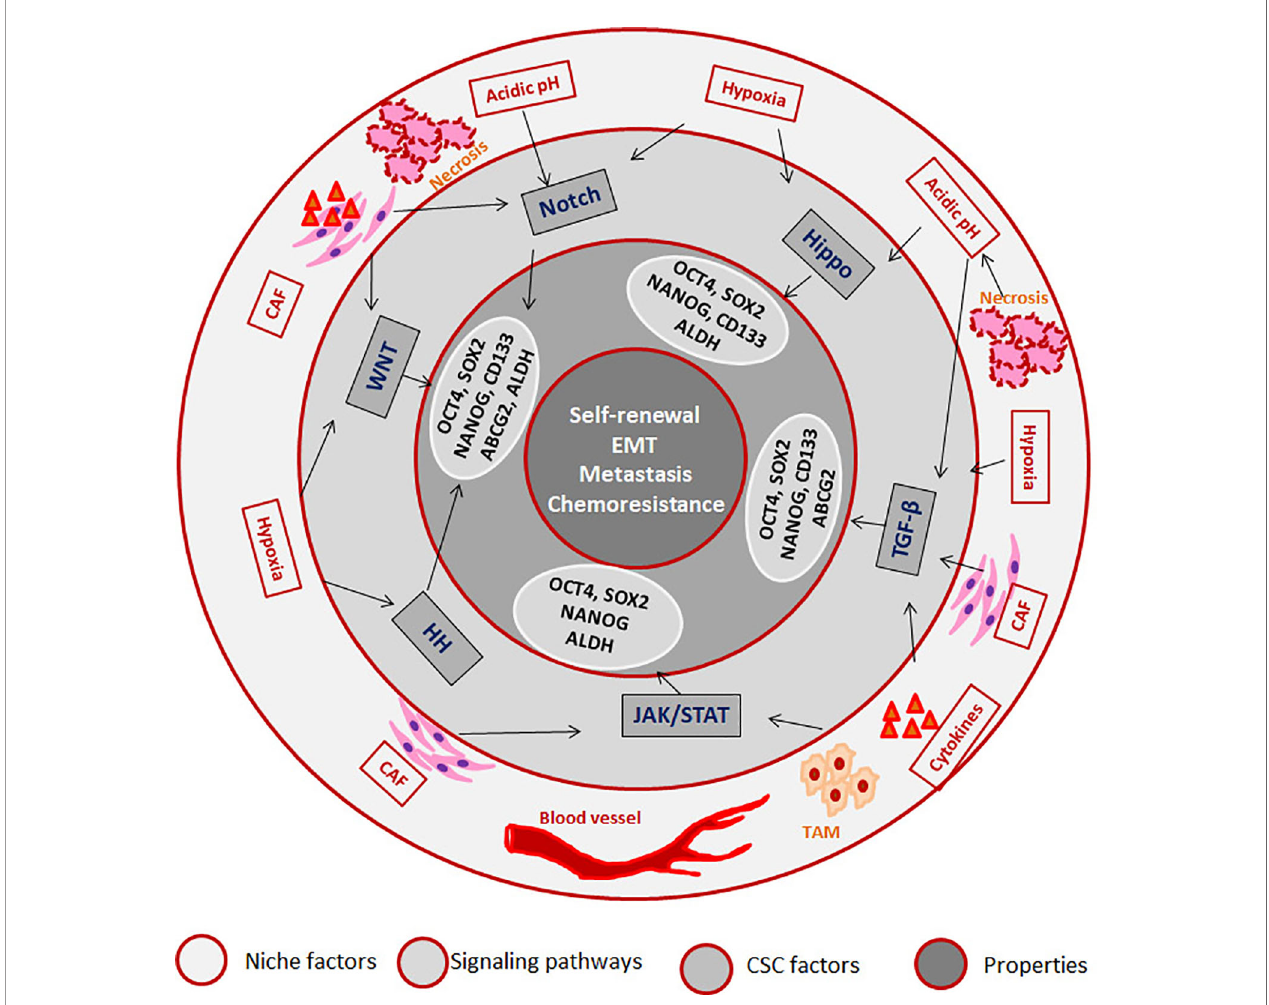
FIGURE 1 | The role of “ CSC niche ” in regulating cancer stem cell properties. The Tumor associated macrophages (TAM) secretes cytokines initiating JAK/STAT and TGF- b signaling pathways. The regions where blood supply reduces creates hypoxia, which activates Hedge Hog (HH) WNT, Notch and Hippo signaling pathways. The regions where there is no oxygen and nutrient supply undergo necrosis, which creates an acidic pH that activates Notch and Hippo. Cancer associated fi broblasts (CAFs) also secret factors that initiate different signaling pathways. As a result of the pathway activation, several CSC-associated molecules are activated that results in the induction of